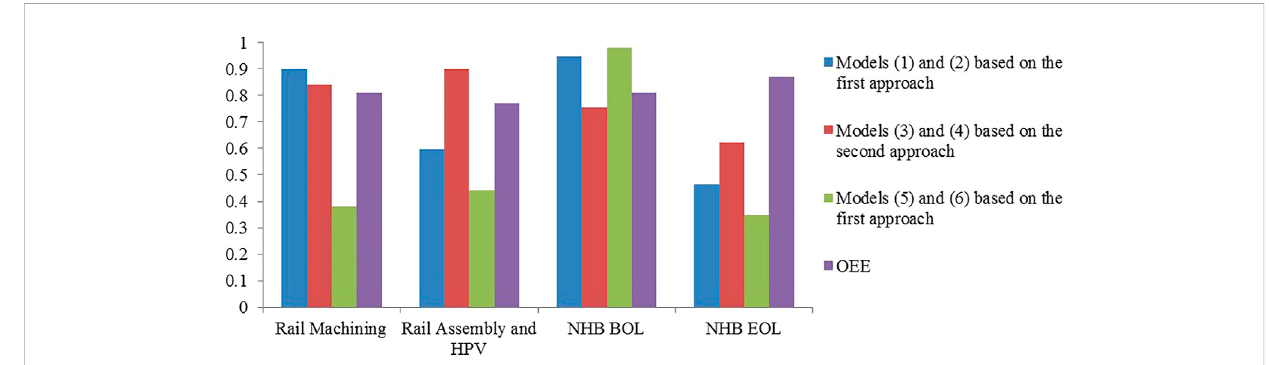
FIGURE 5 The comparisons of TPM performance values with the OEE values with respect to each